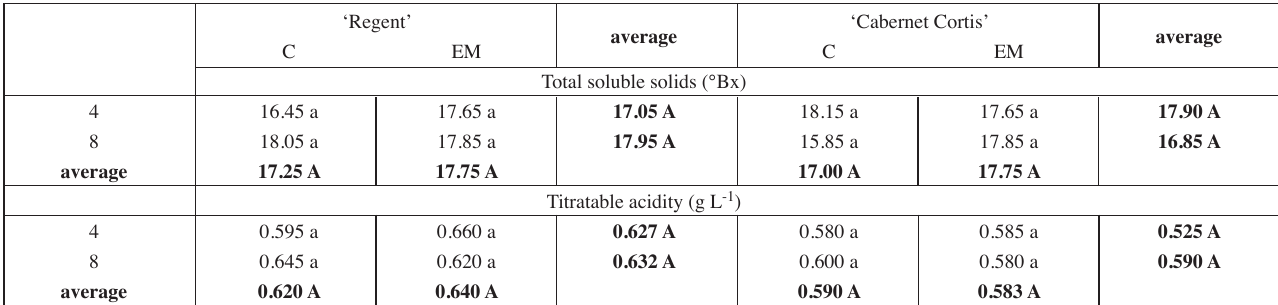
Tab. 3: Effect of the performed treatments on the total soluble solids (in °Bx) and titratable acidity (in g L -1 ) in the fruit of the tested vine cultivars. Means with same letter were not significantly different by Tukey’s comparison at p < 0.05 level. Lowercase letters (a) indicate group means; capital letters (A) indicate group